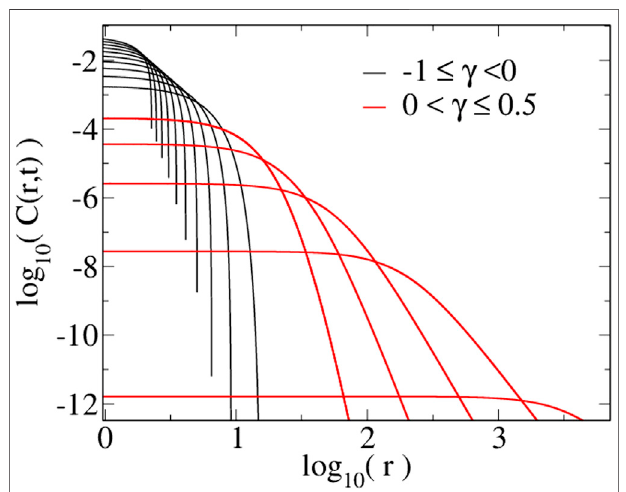
FIGURE 1 | (A) Simulations of r rms compared to the theoretical values of Eq. 13 for the fi nite-interaction range model using N p (cid:1) 10 6 particles and D 0 (cid:1) 1. (B) r rms resulting from the in fi nite-interaction range model using N p (cid:1) 1500 particles. The solid lines show the predicted slope of Eq. 2